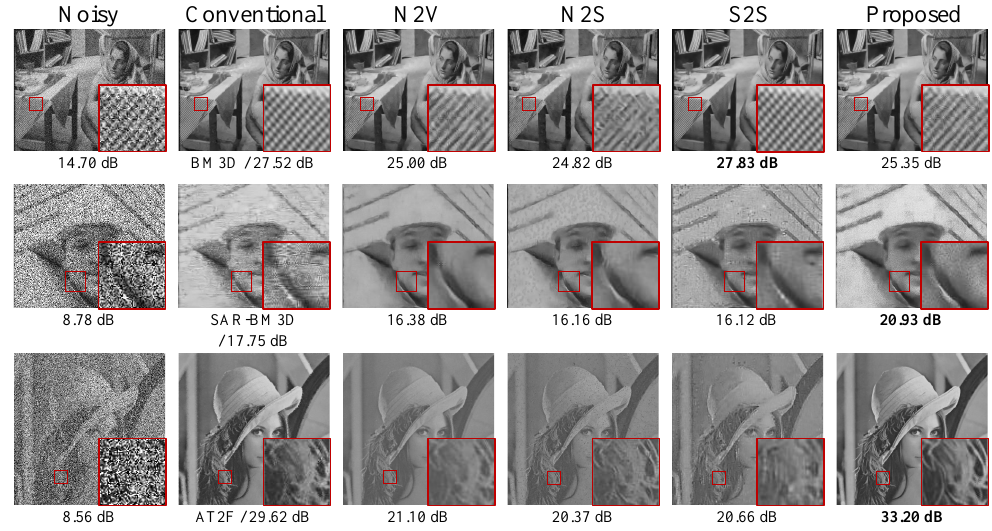
Figure 5. Qualitative performance comparison of various denoising methods on three noise types. Top to bottom row: AWGN ( σ g = 50), speckle noise ( σ s = 50), and salt-and-pepper noise ( d = 50), respectively. The best PSNR in each case is highlighted in bold. Each row indicates the results of AWGN, speckle noise, and salt-and-pepper noise,